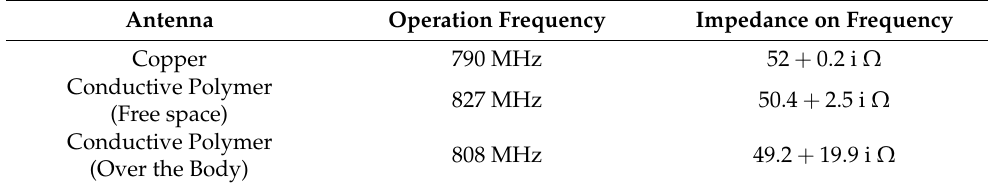
Figure 9. ( a ) The Copper antenna ( b ) The Polymer antenna, sewn on a T-shirt ( c ) Return loss of the antenna in simulation, the Copper antenna, and the Polymer antenna, both in free space and over the body. Table 3. Measured Antenna Specifications.